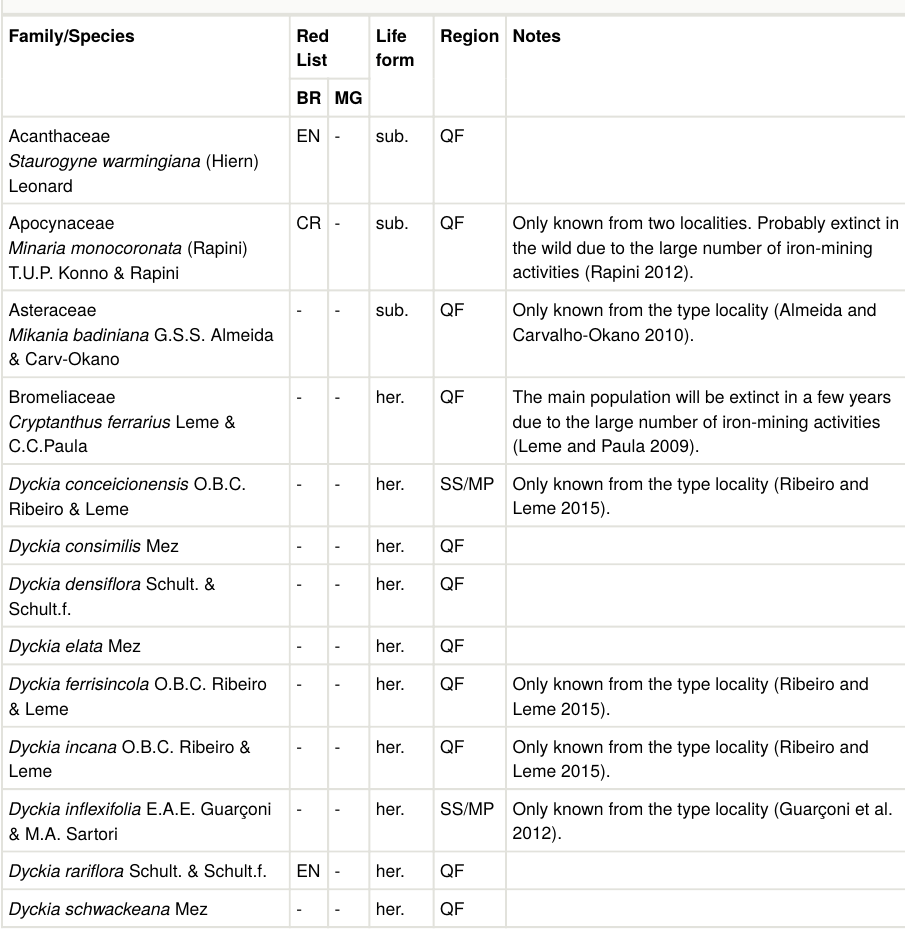
Table 3. List of 48 narrow endemic species in ironstone ranges, south-eastern Brazil. Red List - BR (Brazil 2014) and MG (Minas Gerais 1997): VU: Vulnerable; EN: Endangered; CR: Critically Endangered; EX: Extinct. Life form: shr. (shrub), her. (herbaceous), sub. (subshrub), li. (lianas/vines). Region of occurrence: QF (Quadrilátero Ferrífero), SS-MP (Serra da Serpentina-Morro do Pilar). See references in Suppl. material